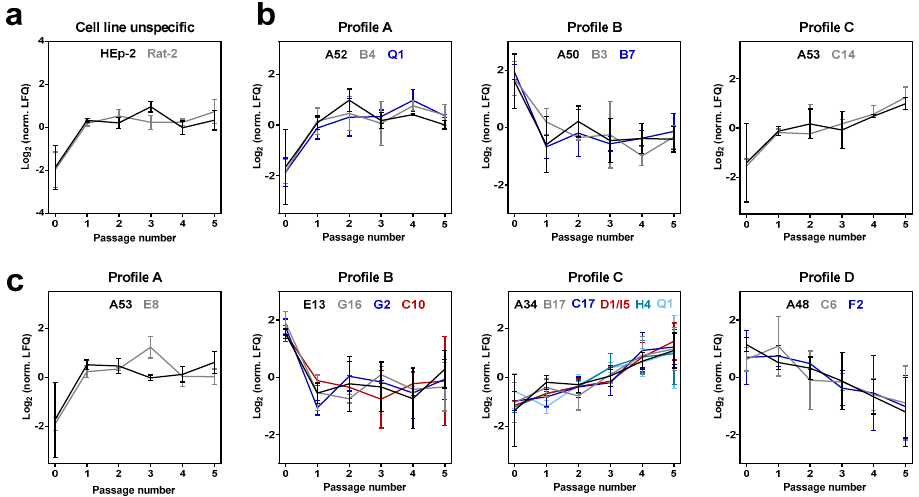
Figure 4. Viral proteins changing in an adaptation-associated manner during passaging in HEp-2 and Rat 2 cells. Proteins are sorted according to adaptation-associated time courses with distances ≤ 0.1 to reference profiles A–D, which are shown in Figure S1. ( a ) A single viral protein (G13) displays comparable courses during passaging in both cell lines (cell line unspecific). Proteins changing in a cell-line-independent manner were identified in ( b ) Rat-2- and ( c ) HEp-2-passaged virions. Shown are normalized LFQ intensities (log 2 ) of ANOVA-significant proteins. Error bars indicate means ± SD of three biological replicates (passages 1–5) or three technical replicates (passage 0: crust).